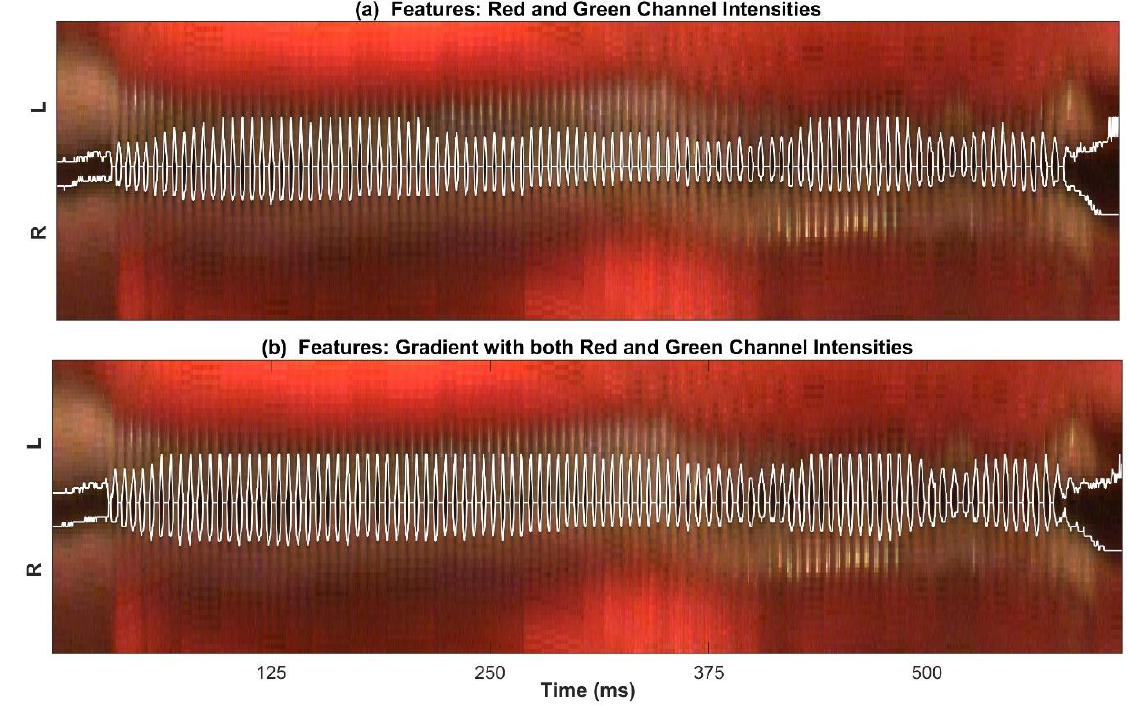
Figure 3. Clustered kymogram (from Figure 1h) by employing the k-means clustering algorithm using ( a ) the red and green channel intensities as features and ( b ) the gradient along with the red and green channel intensities as three features.